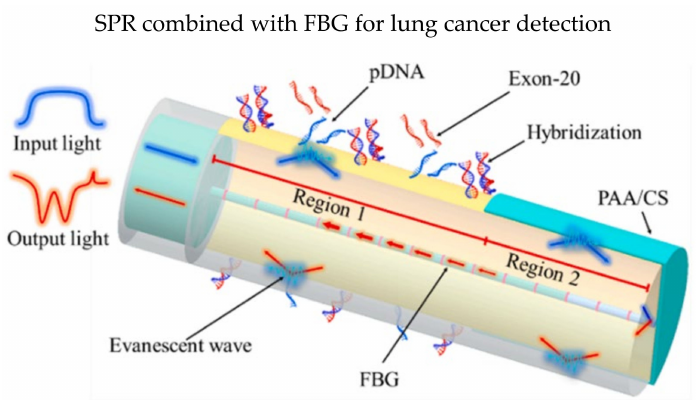
Figure 6. Schematic design and results of the lung cancer biosensor: The FBG region was coated with 35 nm gold film. PAA/CS (poly (acrylic acid)/chitosan) was coated on the region 2 while region 1 was functionalized with Probe DNA sequences for detection of exon-20 gene. Reprinted with permission from Ref. [81]. Copyright 2022,